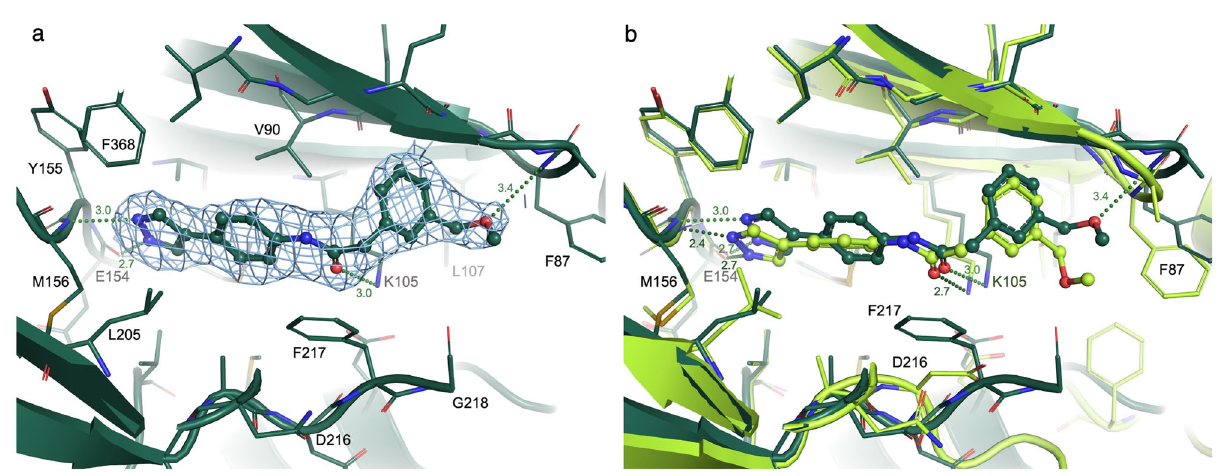
Fig.4|ComparisonoftheX-raystructureofcompound1withitsdockedpose. a X-raystructure:there fi ned2Fo-Fcelectrondensityisdepictedat1sigmacontour